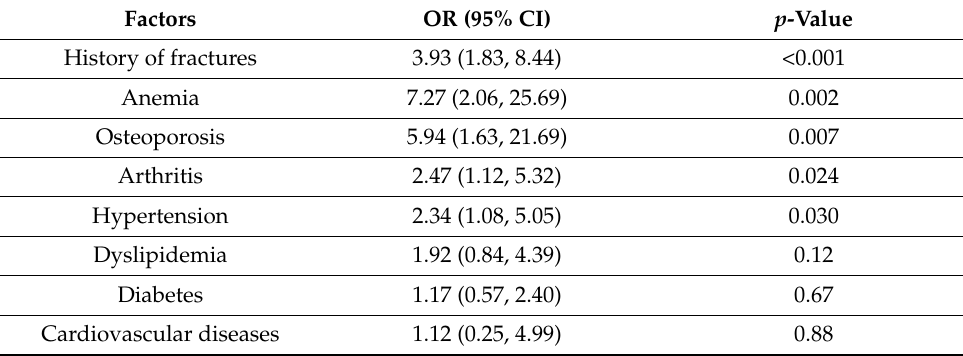
Table 2. Binary logistic regression for low back pain versus risk factors.